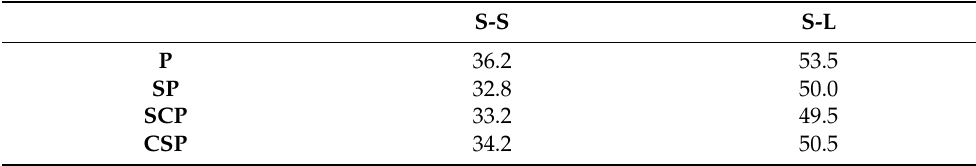
Figure 5. DSC curve of the paraffin/synthetic saponite PCMs and of bulk paraffin. Table 2. Temperature (°C) of the effects recorded in the DSC.